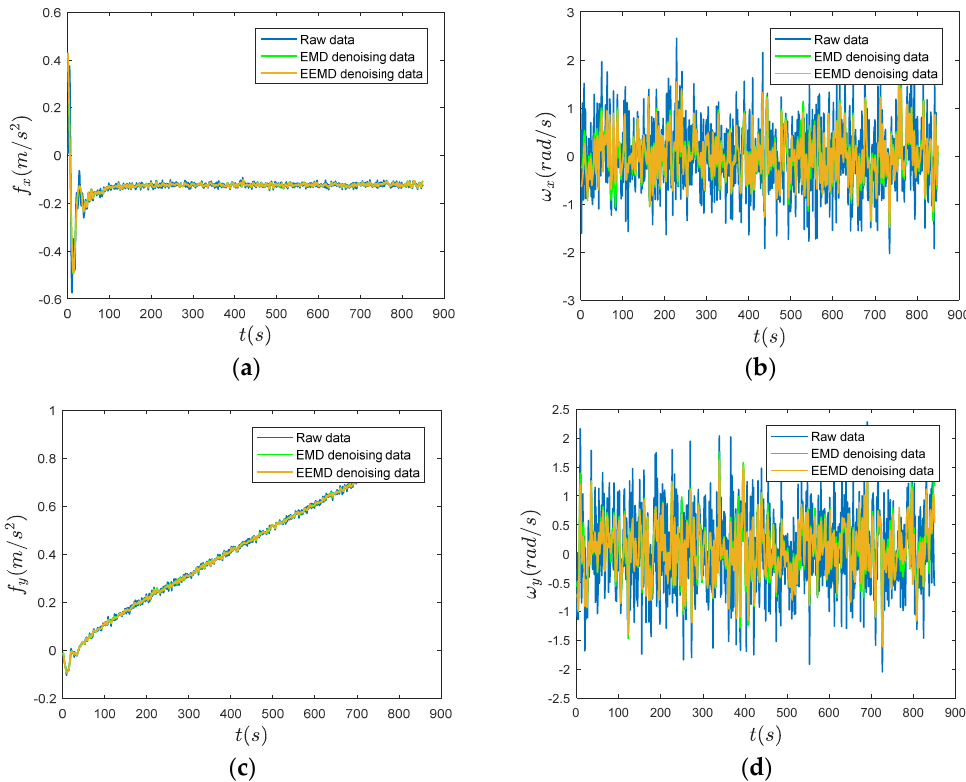
Figure 8. Comparison of specific force and angular velocity denoising effects: ( a ) specific force denoising effect in x − axis; ( b ) angular velocity denoising effect in x − axis; ( c ) specific force denoising effect in y − axis; ( d ) angular velocity denoising effect in y − axis. Table 4. RMSE effect evaluation.